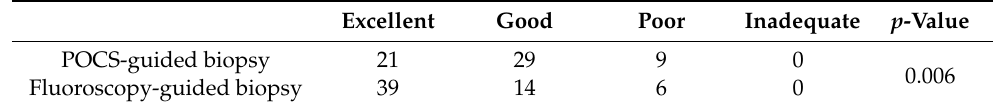
Table 4. Pathological assessment of the quality of biopsy